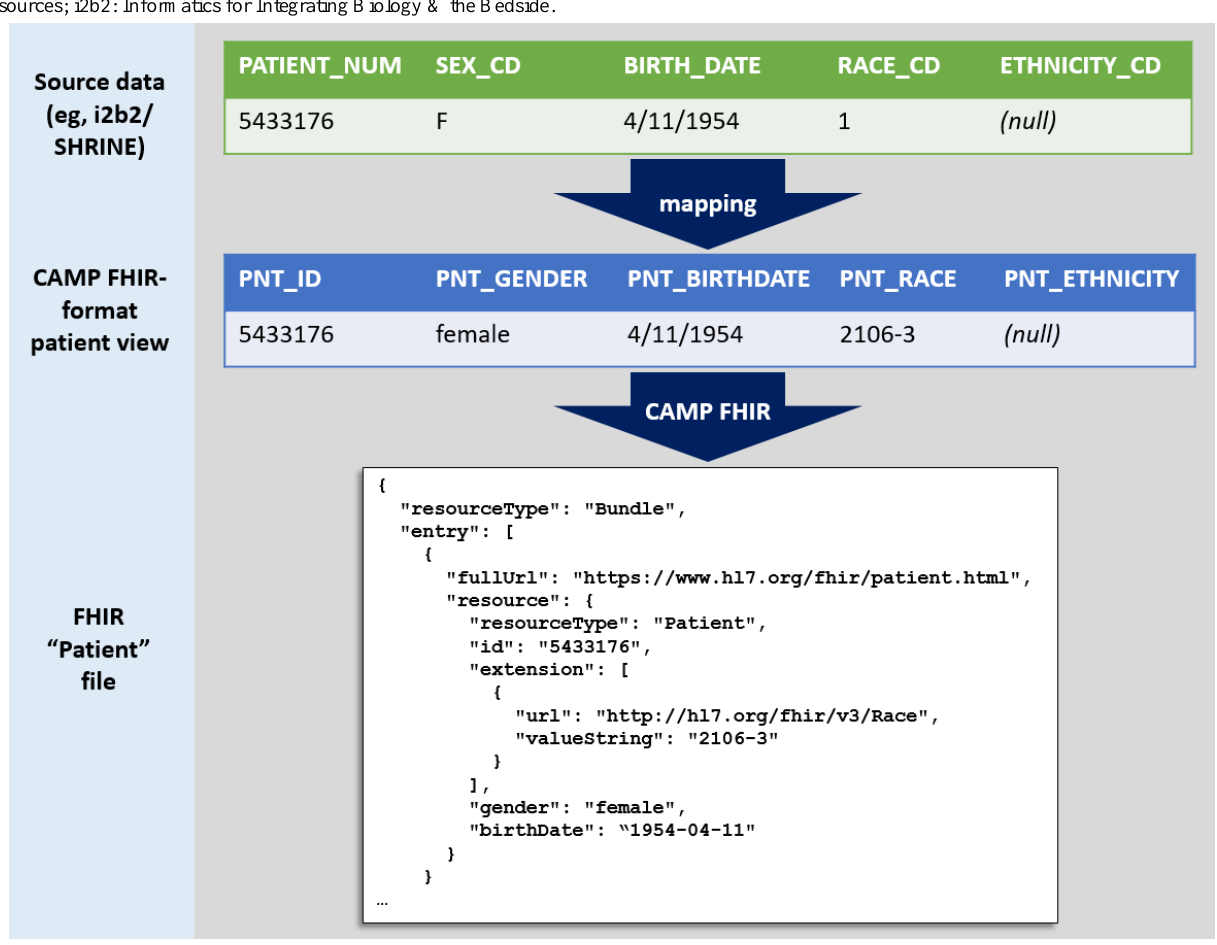
Figure 1. An example of demographic data transformation. CAMP FHIR: Clinical Asset Mapping Program for Fast Healthcare Interoperability Resources; i2b2: Informatics for Integrating Biology & the Bedside.